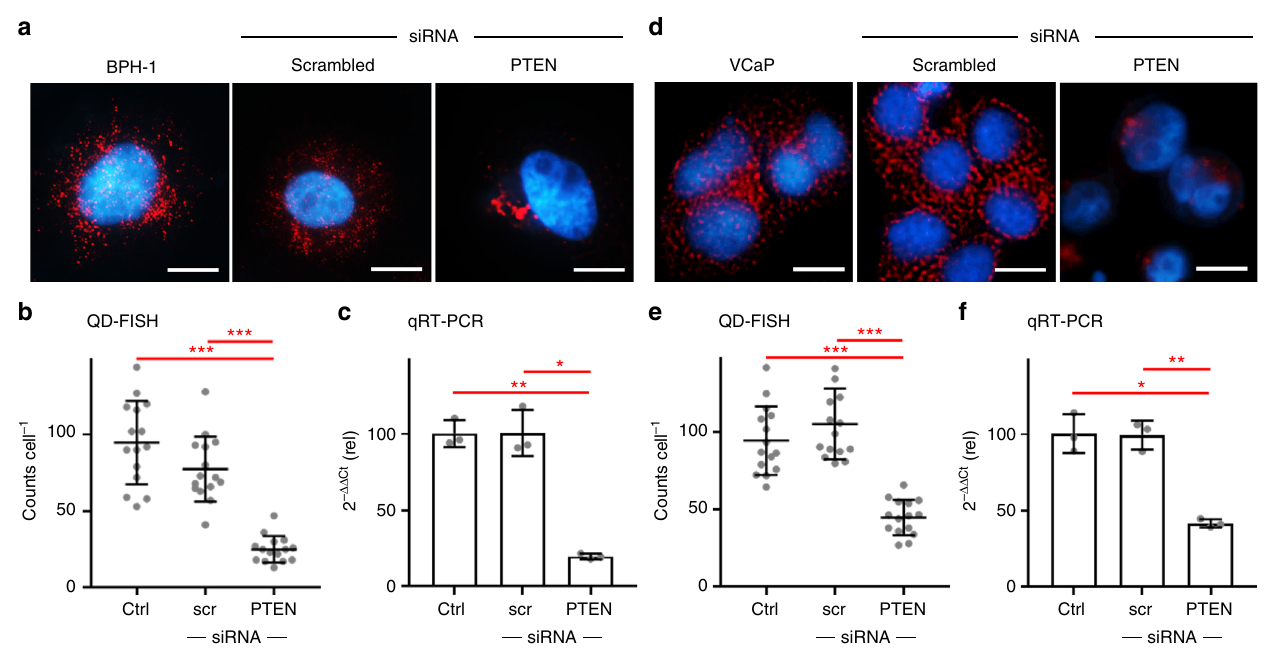
Fig. 3 QD-FISH analysis of phosphatase and tensin homolog ( PTEN ) transcripts in prostate cancer cell lines. Representative images show BPH-1 cells ( a ) and VCap cells ( d ) with or without treatment by siRNA to knock down PTEN expression, or using a scrambled siRNA sequence. Scale bar = 10 μ m. Single-cell QD-FISH counts are shown for ( b ) BPH-1 cells and ( e) VCaP cells, in comparison with transcript measurements by population qRT-PCR for ( c ) BPH-1 cells and ( f ) VCap cells. Signi fi cantly reduced mRNA levels are observed for anti- PTEN siRNA treatment, with a similar magnitude between QD-FISH and qRT- PCR. Asterisks indicate: p ≤ 0.05 (*), p ≤ 0.01 (**), and p ≤ 0.001 (***); Student ’ s t -test. All error bars represent s.d. N = 15 for ( b ) and ( e ), N = 3 for ( c ) and ( f ). Comprehensive statistical comparisons are provided in Supplementary Tables 4 – 7. PTEN mRNA FISH probe sequences are shown in